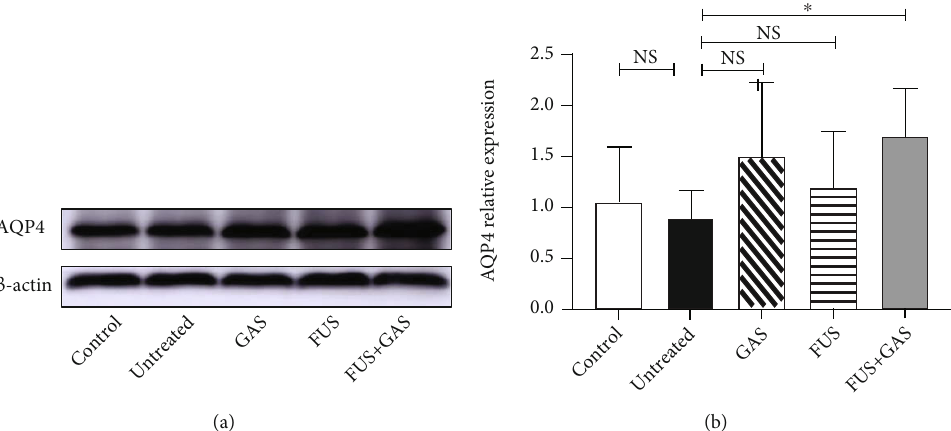
Figure 9: WB analysis of AQP4 level in sonicated hippocampus 15-days after interventions. The combined treatment of BBB opening via FUS and GAS remarkably increased the content of AQP4 in the targeted hippocampus, indicating a stronger waste-cleaning function. Each symbol represents the mean ± SD ; ∗ P < 0 : 05 against untreated mice. One-way ANOVA; n = 5 per